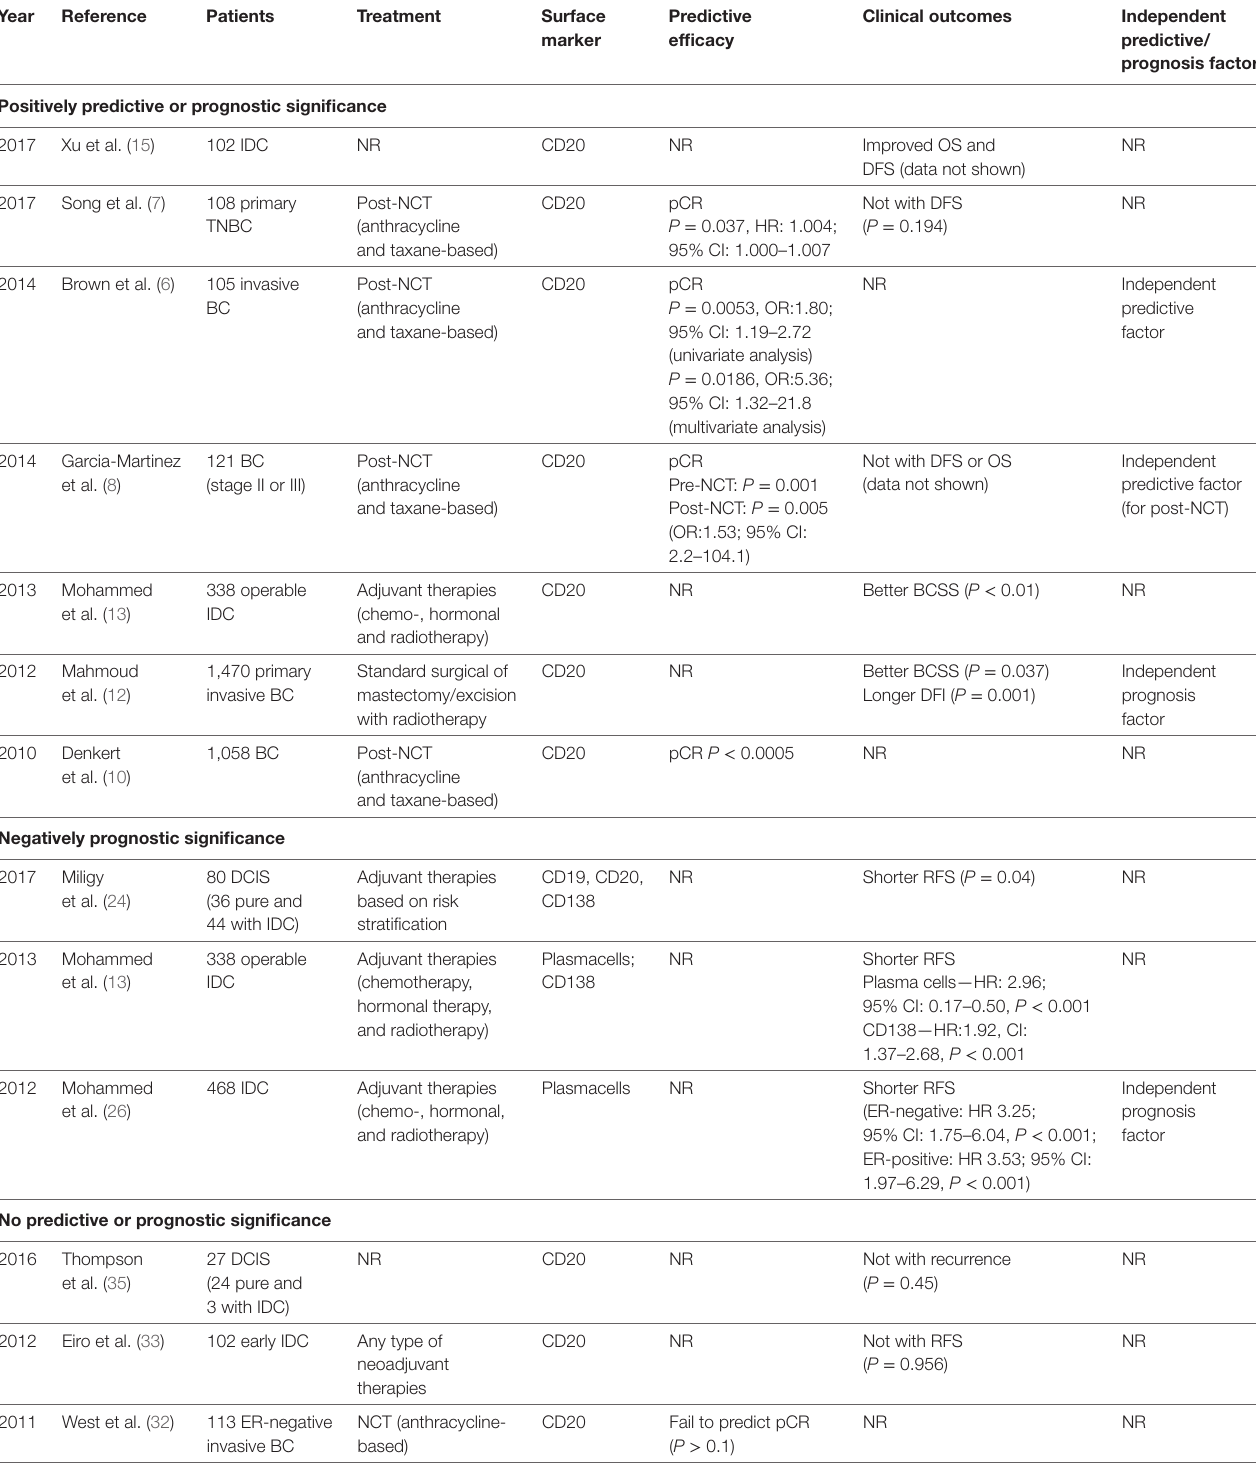
TABLe 1 | Clinical experiments involving predictive or prognostic significance of tumor-infiltrating B cells in